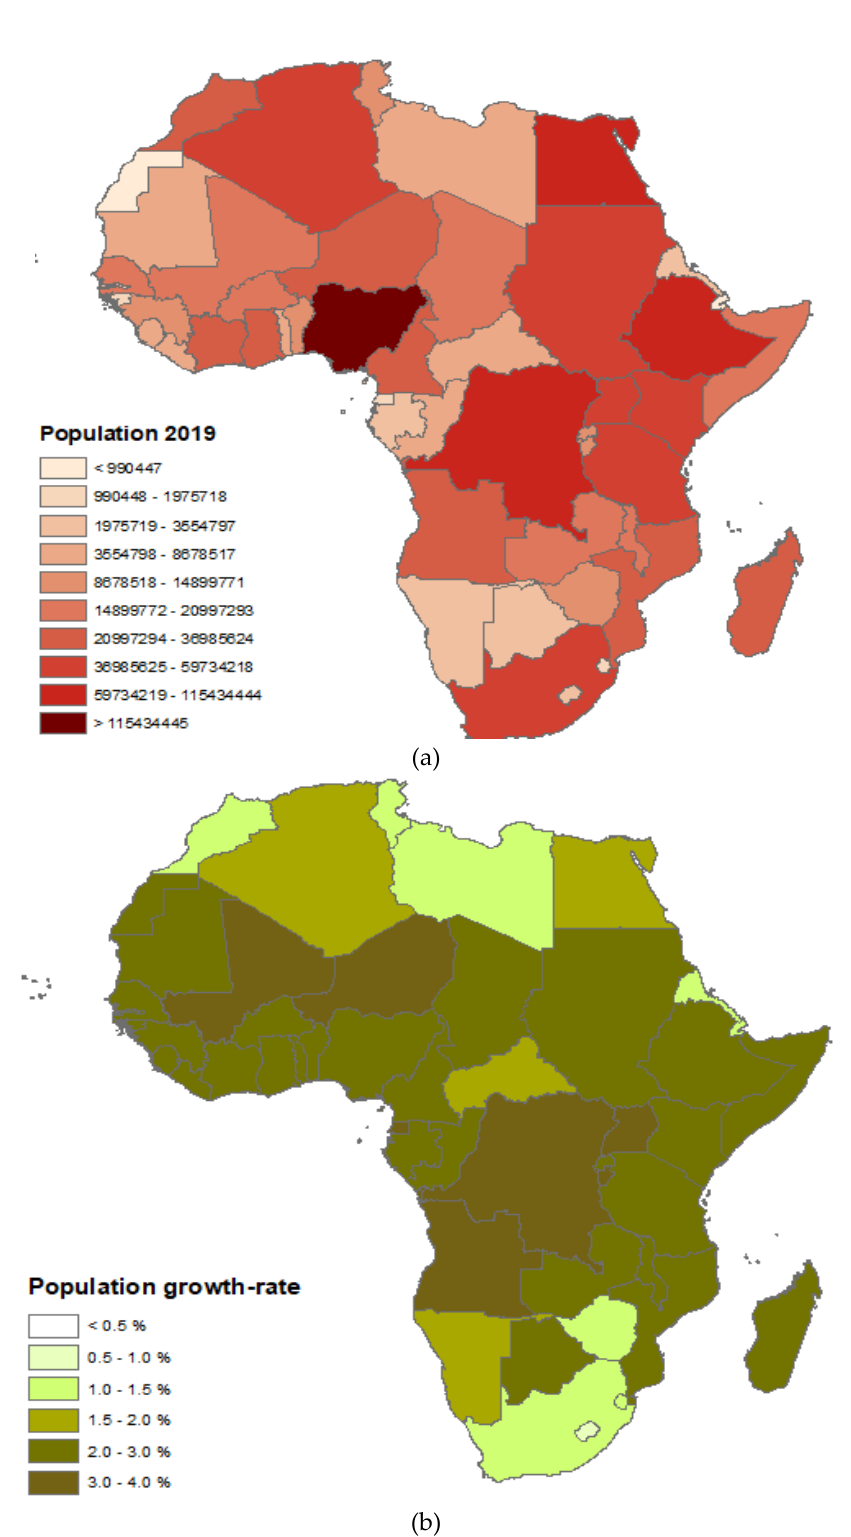
Figure 5. Africa Population in million ( a ), and Population growth rate ( b ). Sources: Authors’ compilation, analysis and mapping from UN-DESA, WB, and WDI data- bases.